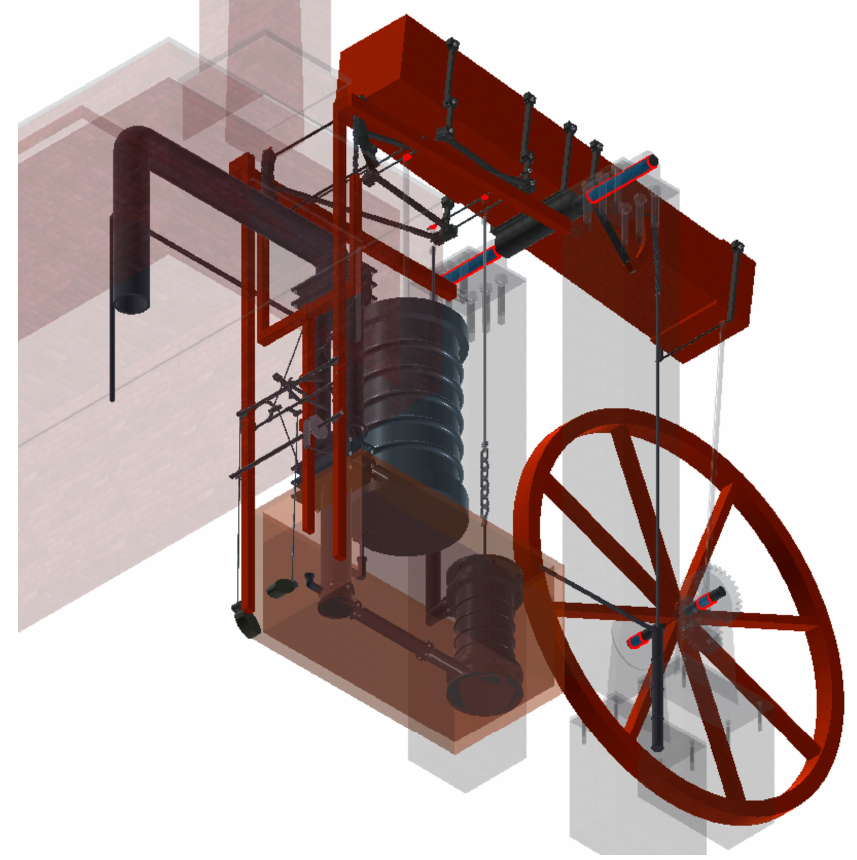
Figure 6. Rotary supports. Figure 6. Rotary